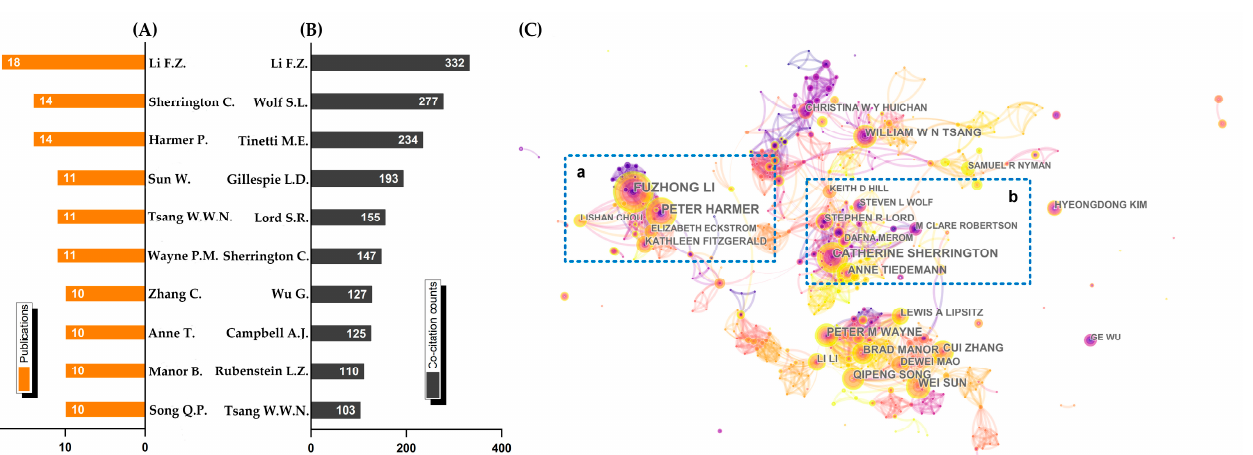
6 of 18 Figure 5. Visualized map of the leading journals. ( A ) Top ten journals by publications ; ( B ) top ten journals by impact factor (IF) in 2020; ( C ) top ten co-cited journals based on citation counts. Note: The WoS provided the publications and impact factor (IF), and Citespace provided the citation